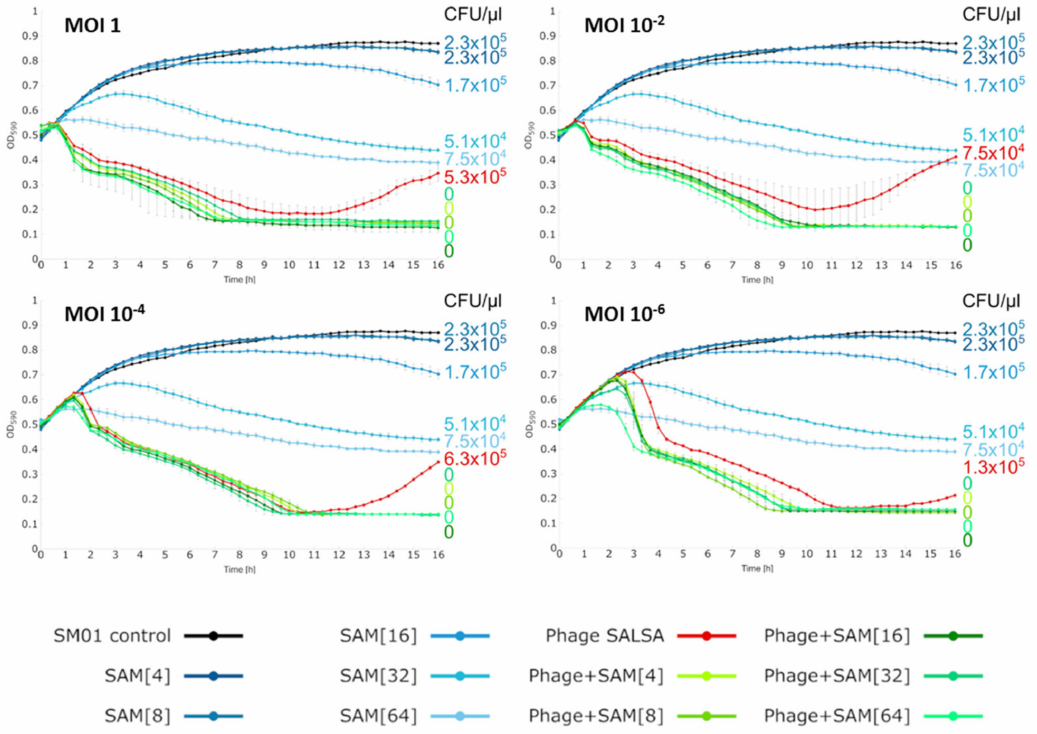
Figure 4. Liquid infection assays against S. marcescens strain SM01 with or without various concentrations (mg / L) of the antibiotic ampicillin / sulbactam (SAM). Reduction was measured via optical density at 590 nm (OD 590 ). Each experiment was performed in triplicate and the means ± standard errors are indicated. The number of colony forming units / µ L (CFU / µ L) after 16h is given on the right side. Data are from one set of experiments but are shown in four graphs for better visibility of the phage / antibiotic